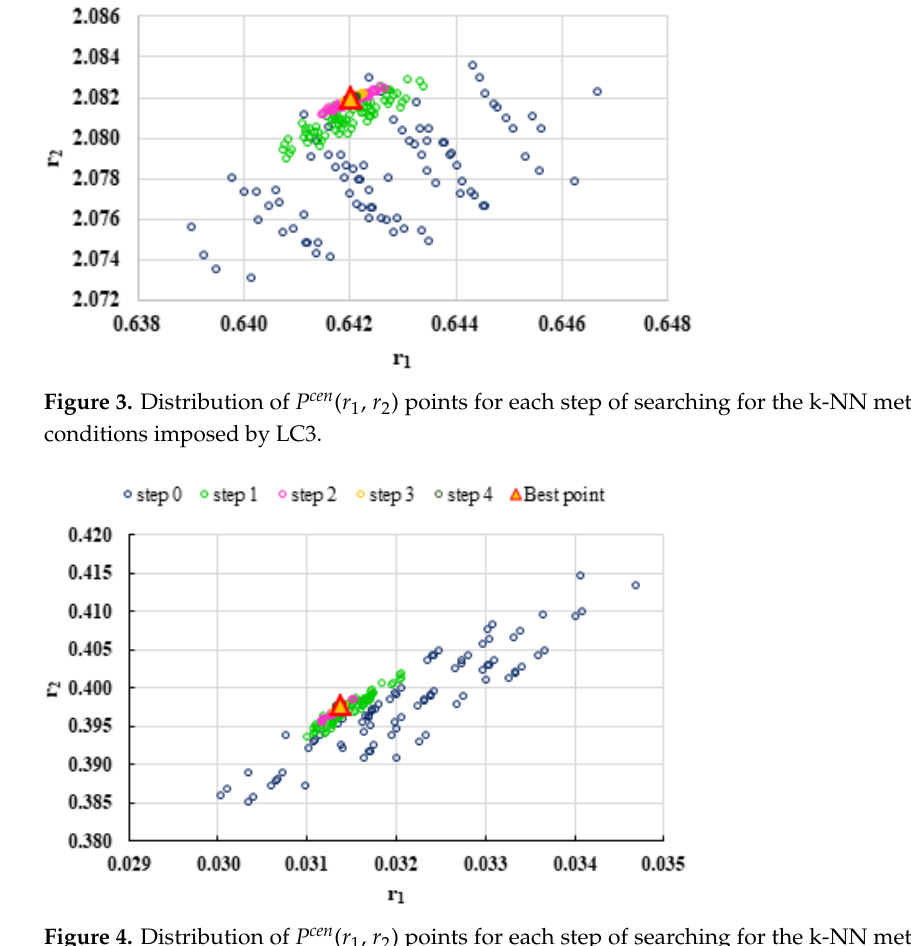
Figure 5. Distribution of P cen (r 1 , r 2 ) points for each step of searching for the k-NN method for the conditions imposed by MC2.